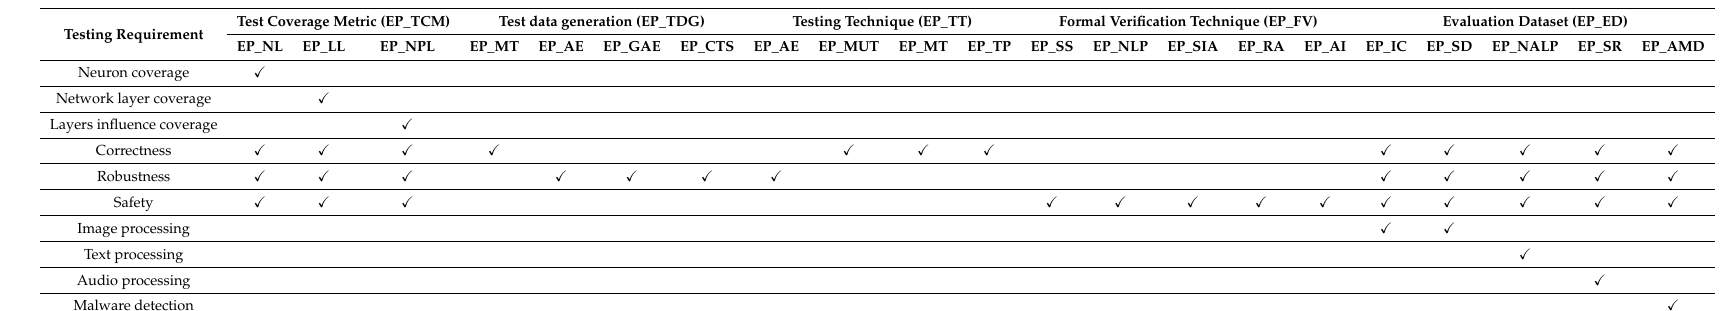
Table 2. Summary of testing strategy recommendation with extension points provided in